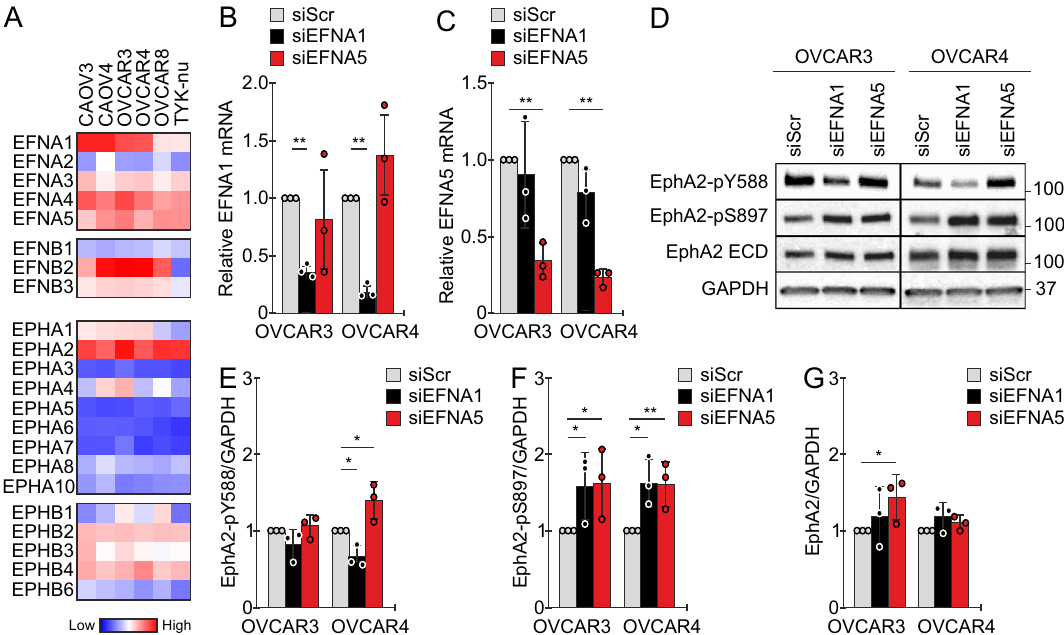
Figure 2. Canonical EphA2-pY588 activation remains unaltered or is even increased after depletion of EFNA5 . ( A ) Heat map for ephrin ligands and Eph receptor mRNAs in selected HGSC cell lines. Data obtained from CCLE and illustrated per cell line. ( B , C ) Quantification of EFNA1 ( B ) and EFNA5 ( C ) mRNAs in OVCAR3 and OVCAR4 with silenced EFNA1 or EFNA5 compared to the controls. N = 3. siScr is set to one. ( D – G ) EphA2 (total and phosphorylated) in OVCAR3 and OVCAR4 after silencing of EFNA1 or EFNA5 ( D ) along with EphA2-pY588 ( E ), EphA2-pS897 ( F ), and EphA2 ( G ) quantifications. N = 3. siScr is set to one. Full-length blots are presented in Supplementary Fig. 5. p values (Student’s t-test): *< 0.05; **<